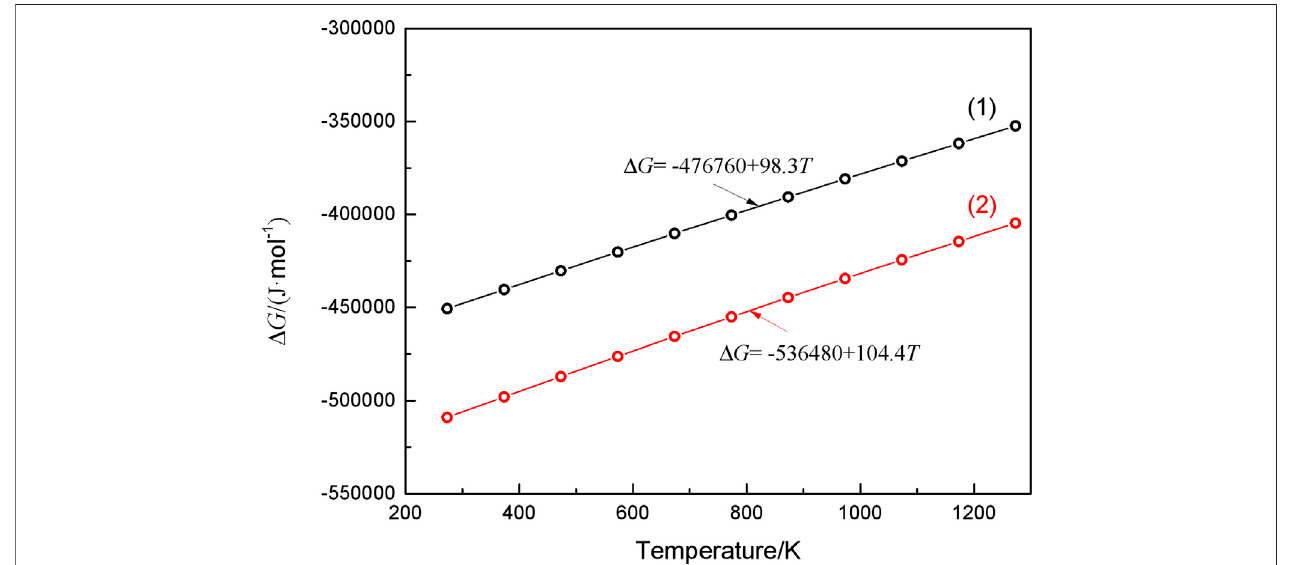
FIGURE 10 | The change in Gibbs free energy ( Δ G ) for the oxidation of component in WC-Y 2 O 3 cemented carbide.